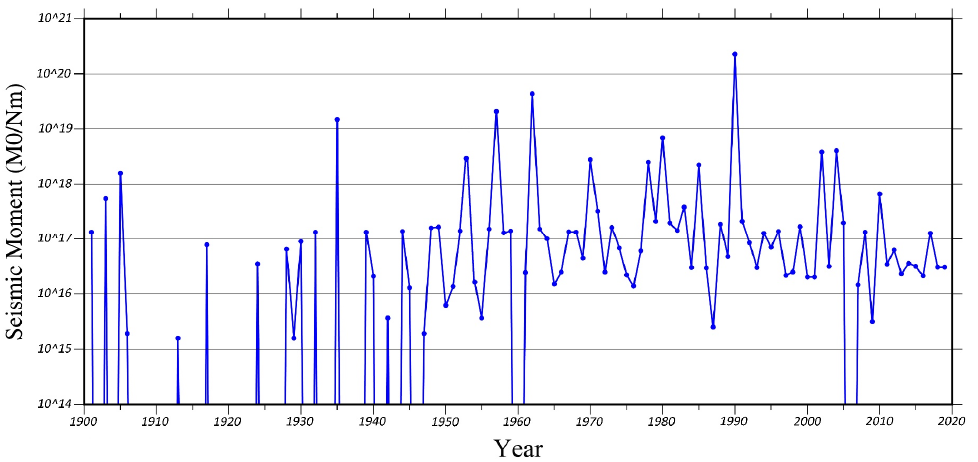
constant parameters related to the law suggested by Hanks and Kanamori [86].